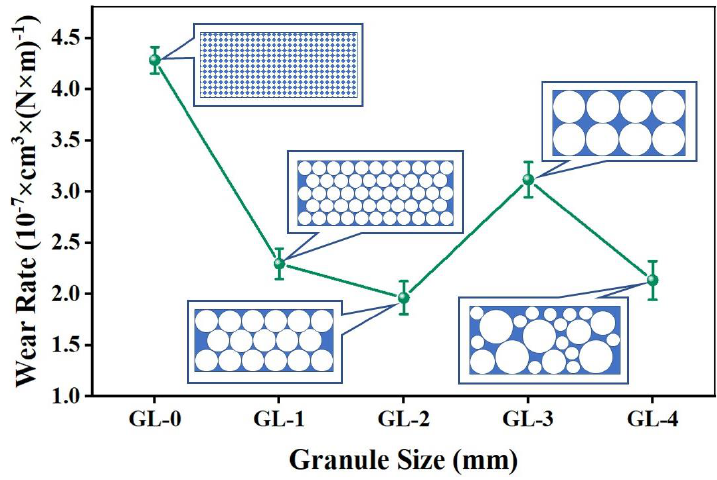
Figure 4. Wear rate of